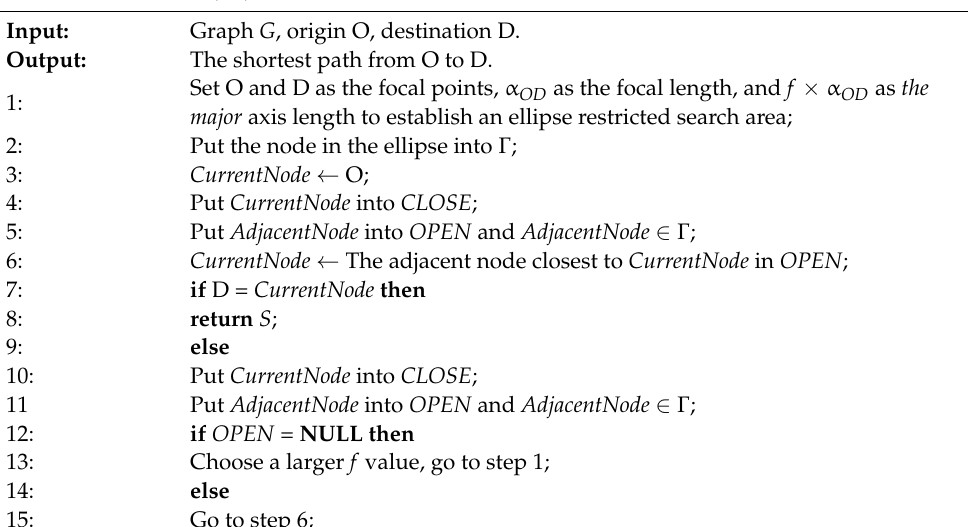
Algorithm 1 The Shortest Path Algorithm based on Ellipse Restricted Search Area